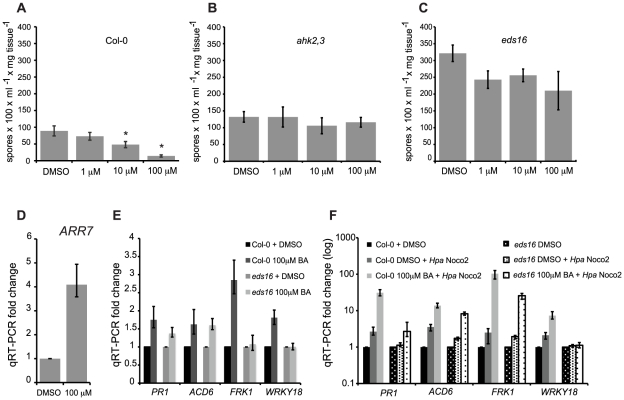
High concentrations of cytokinin prime defense responses via SA accumulation.Susceptibility of cytokinin-treated wild-type (A), ahk2,3 (B) or eds16 (C) plants to Hpa Noco2. Two-week-old plants were sprayed with the indicated concentrations of BA or DMSO control 48 hours prior to inoculation with Hpa Noco2. Spore production was measured as described in Methods. Error bars represent SE (n≥4). Asterisks indicate statistically significant differences from wild-type plants (p-value<0.05, two-tailed student's t-test). The experiment was conducted in parallel for all genotypes above and repeated at least three times independently. Data from one representative experiment are shown. (D) ARR7 expression in response to cytokinin treatment. RNA was extracted from two-week-old wild-type plants from (A) that had been sprayed with the indicated concentration of BA or DMSO control, 48 hours after treatment. Levels of ARR7 were determined by qRT-PCR relative to DMSO samples. Error bars represent SE from three technical replicates and correspond to upper and lower limits of 95% confidence intervals. At least three independent biological replicates of the experiment were conducted with similar results. Data from one representative independent biological replicate are shown. (E) Expression of defense genes after cytokinin treatment. Two-week-old wild-type and eds16 plants were treated with the indicated concentration of BA or DMSO. RNA was extracted from tissue 48 hours after treatment. Transcripts levels were determined by qRT-PCR relative to samples treated with DMSO. Error bars represent SE from three technical replicates and correspond to upper and lower limits of 95% confidence intervals. At least three independent biological replicates of the experiment were conducted with similar results. Data from one representative independent biological replicate are shown. (F) Defense gene expression is enhanced by pre-treatment with cytokinin. Two-week-old wild-type and eds16 plants were pre-treated with the indicated concentration of BA or DMSO control 48 hours prior to inoculation with water or Hpa Noco2. RNA was extracted from tissue harvested at 3 dpi. Transcripts levels were determined by qRT-PCR relative to the respective DMSO-treated genotypes. Error bars represent SE from three technical replicates and correspond to upper and lower limits of 95% confidence intervals. At least three independent biological replicates of the experiment were conducted with similar results. Data from one representative independent biological replicate are shown.